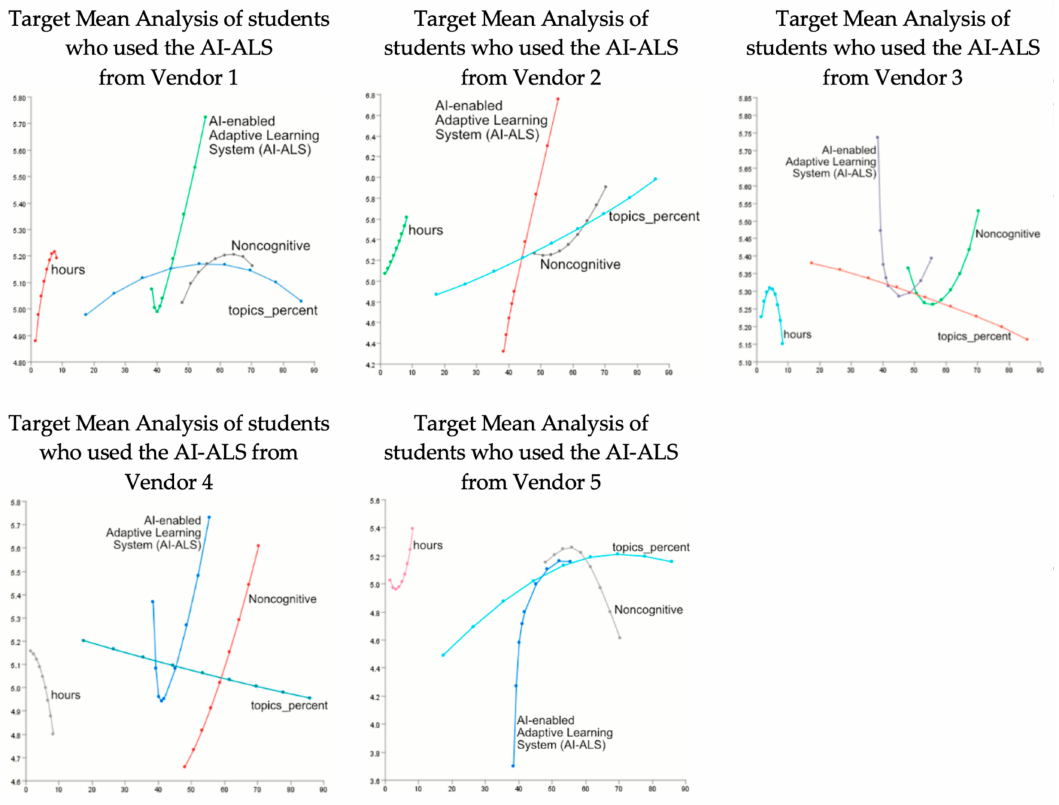
Figure 13. Target Mean Analysis of five di ff erent groups of students, each of which had used an AI-ALS from a di ff erent